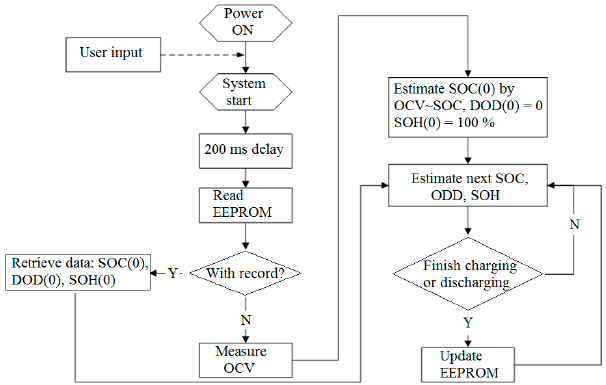
Figure 3. Flowchart of SOC self-initialization and updating (DOD: depth of discharge, SOH: state-of-charge, OCV: open circuit voltage, EEPROM: electrically erasable programmable read-only memory).